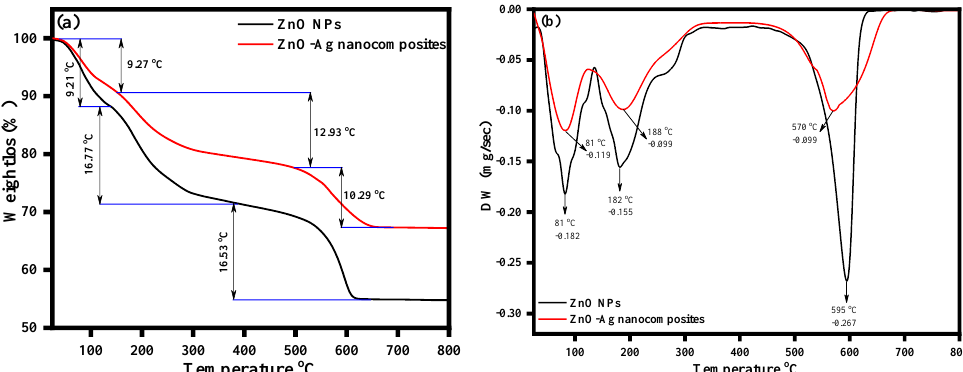
Figure 9. ( a ) Thermogravimetric analysis and ( b ) differential thermal analysis (TGA-DTA) of ZnO and ZnO–Ag